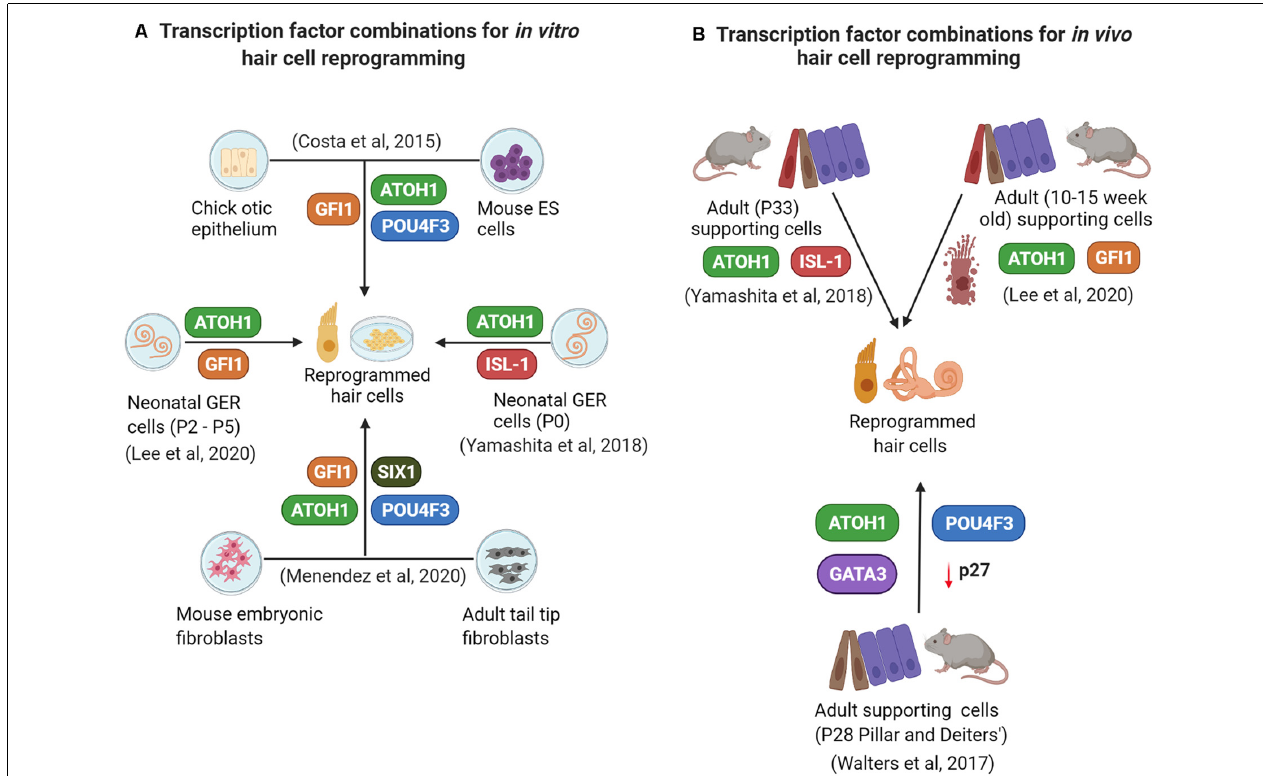
FIGURE 2 | A summary of some current in vitro (A) and in vivo (B) reprogramming studies employing overexpression of different transcription factor